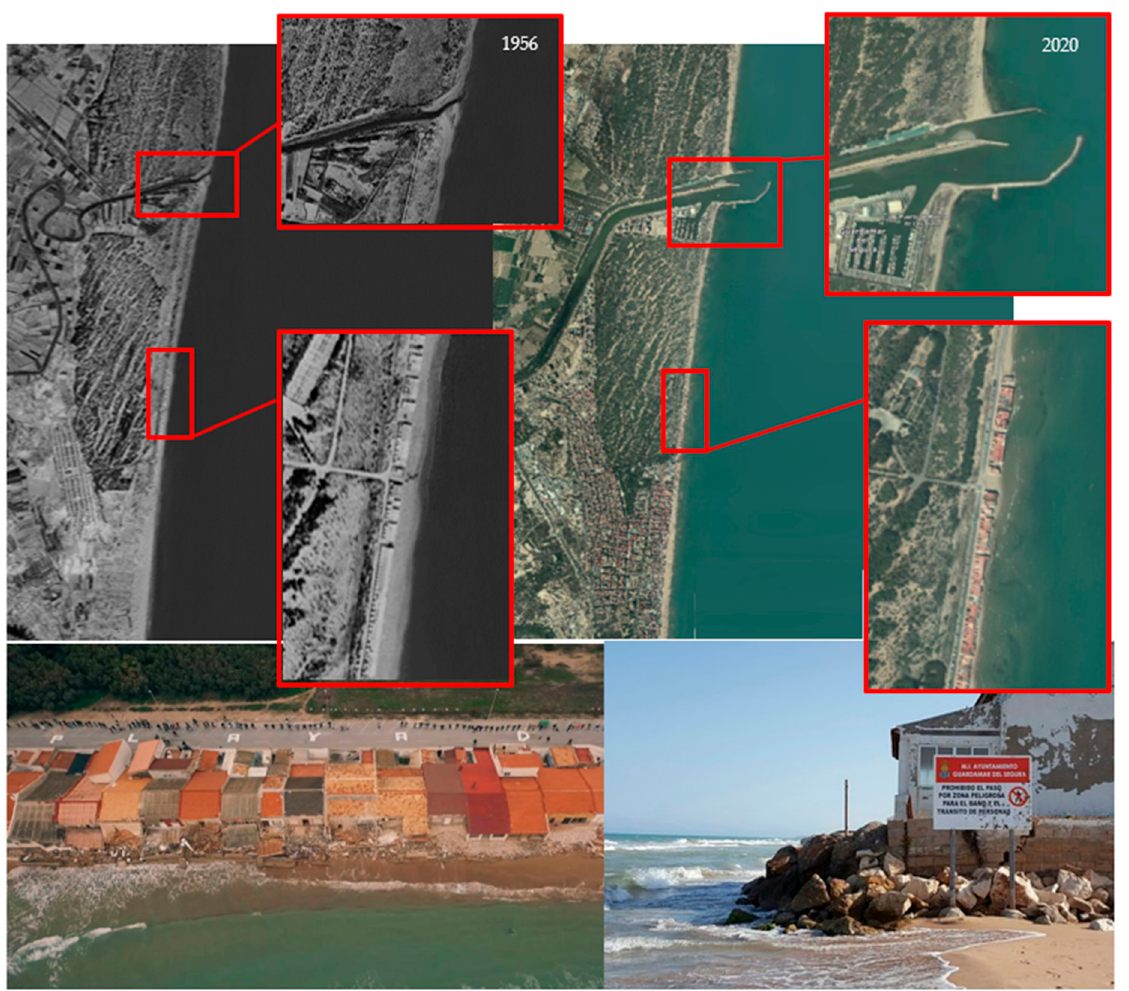
Figure 10. Transformation of the mouth of the Segura River and the beach line between 1956 and 2020 (above). Neighborhood protests for the destruction of centuries-old houses by waves and storms due to the disappearance of the beach (below). Source: Insituto Geográfico Nacional de España, and Plataforma vecinal Playa Babilonia.